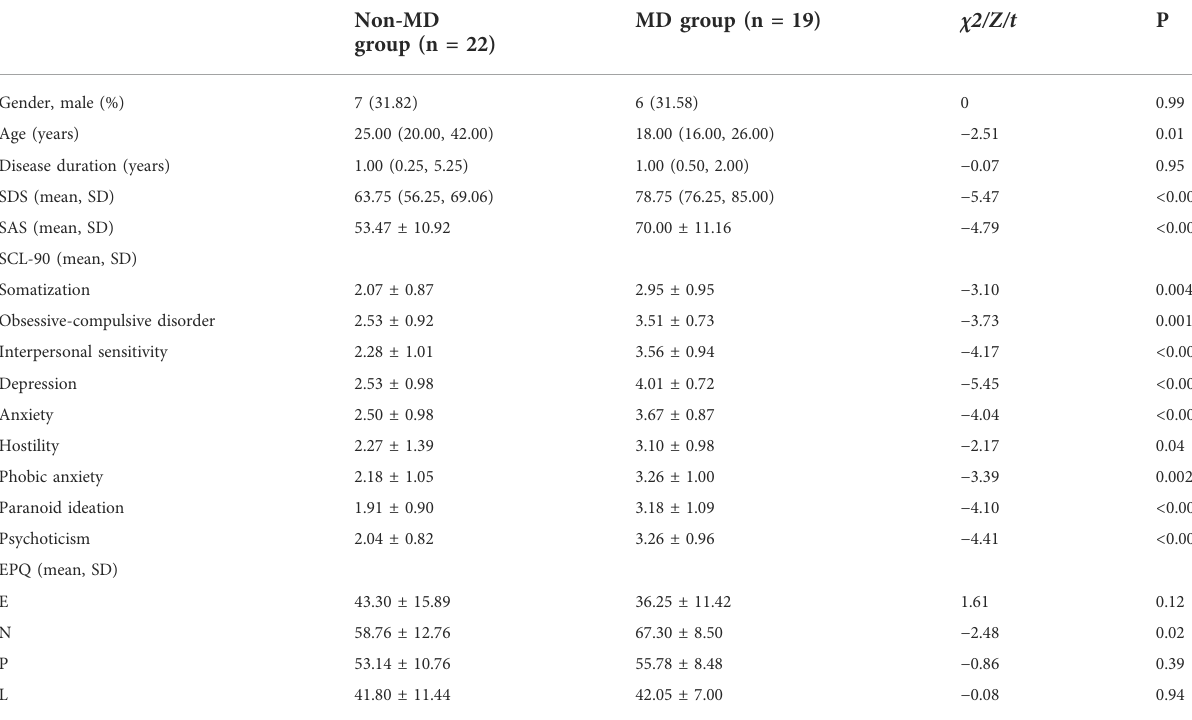
TABLE 2 Clinical and demographic characteristics in the non-major depression group and the major depression